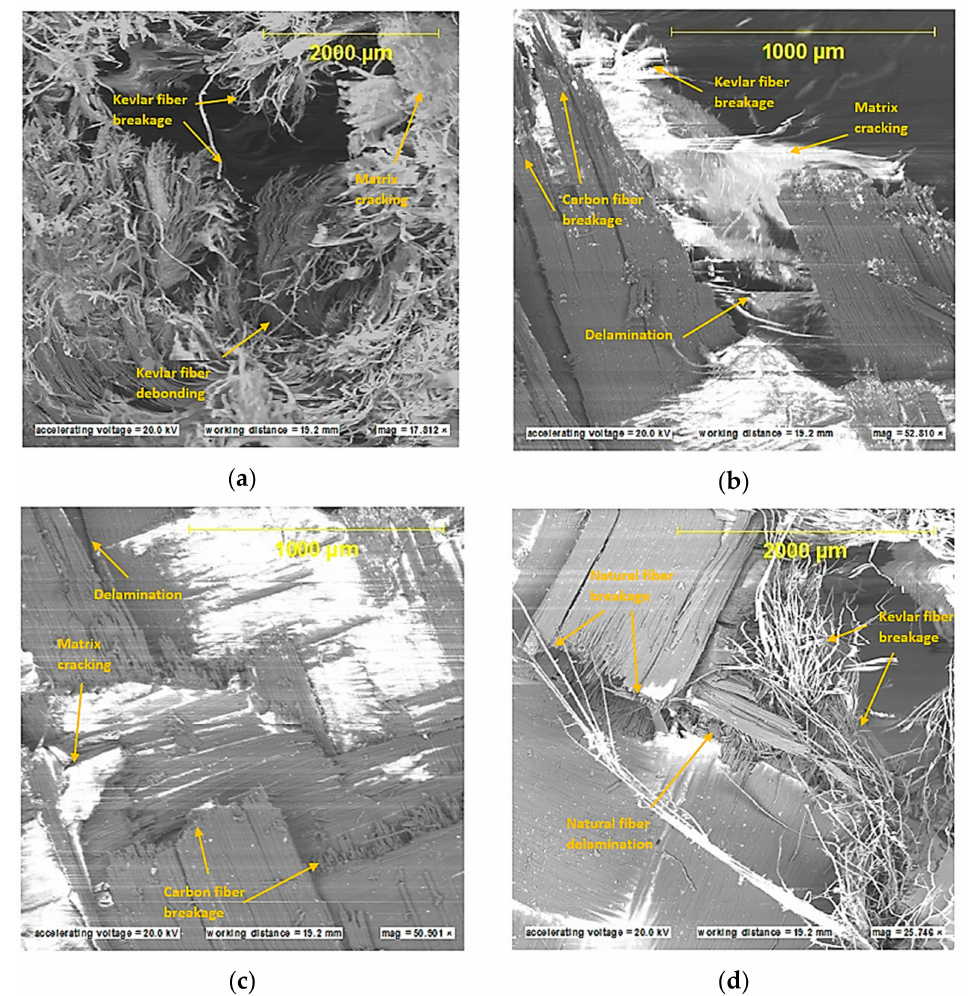
Figure 8. SEM images of strike face for the ballistic tested body armor plates: ( a ) flat non-hybrid KFRP plate (#1), sample 1, shoot 1; ( b ) flat hybrid [CFRP 4 /KFRP 6 ] 4 plate (#3), sample 1, shoot 1; ( c ) flat hybrid [CFRP 10 /KFRP 30 ] (#5) plate, sample 1, shoot 1; ( d ) flat [CFRP 4 /[DPRP 2 /KFRP 10 ] 3 ] plate (#7), sample 3, shoot